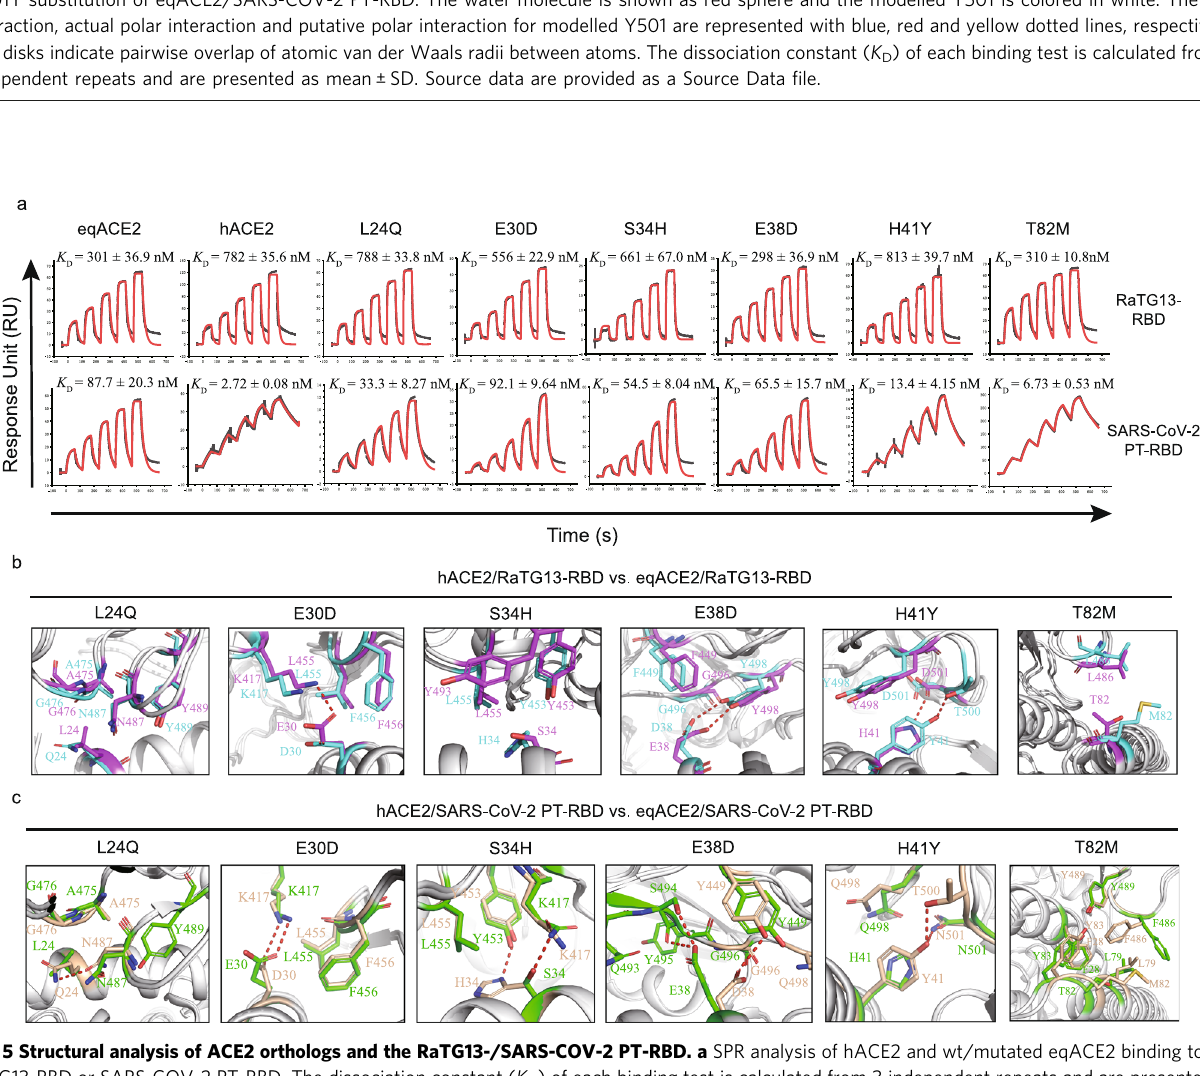
To explain the cross-immunity of CB6 against RaTG13-RBD, we labelled the overlapping residues of SARS-COV-2 PT-RBD bound by both eqACE2 and CB6 48 and compared their counterparts on RaTG13-RBD (Supplementary Fig. 5c, d). We found that 9 out of 13 overlapping residues are conserved between the SARS-COV-2 PT-RBD and RaTG13-RBD (Supple- mentary Fig. 5e), which may render CB6 capable of competitively blocking the RaTG13-RBD from binding to eqACE2.